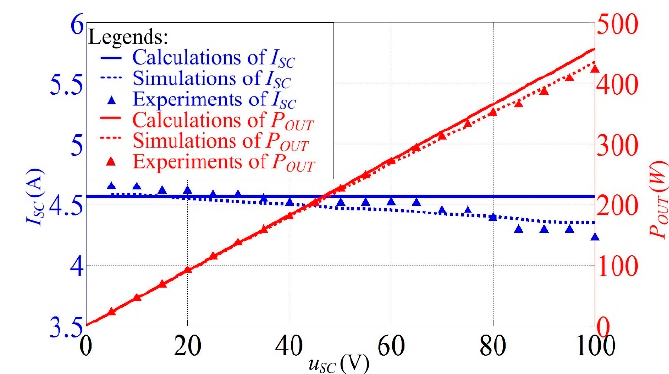
Figure 15. Calculations, simulations, and experiments of I SC , P OUT .